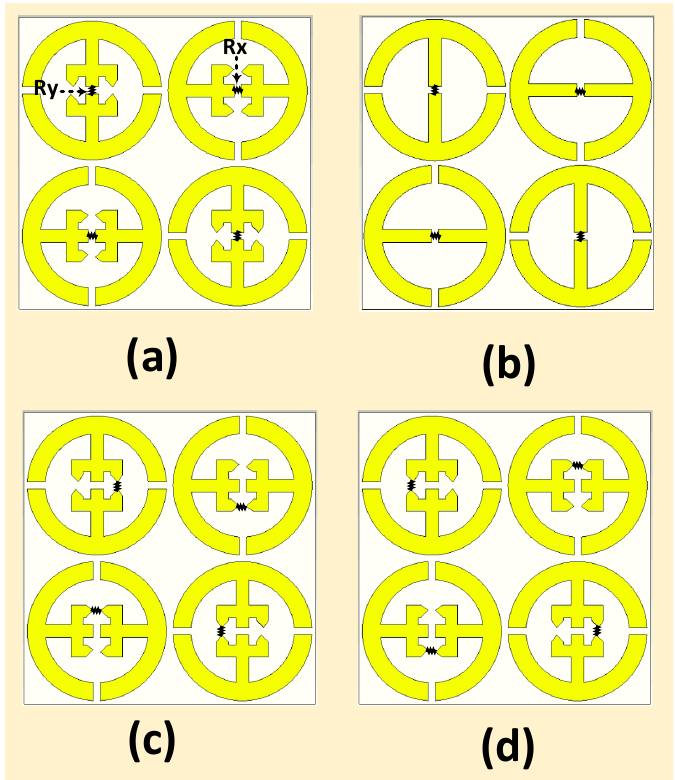
Figure 8. An illustration showing the four cases of the proposed dual polarized planar supercell: ( a ) the main proposed supercell with three extended arms where the load resistance is placed in the middle arm, ( b ) the main proposed supercell without three extended arms where the load resistance is placed in the middle arm, ( c ) the main proposed supercell without three extended arms where the load resistance is placed in the right arm, and ( d ) the main proposed supercell without three extended arms where the load resistance is placed in the left